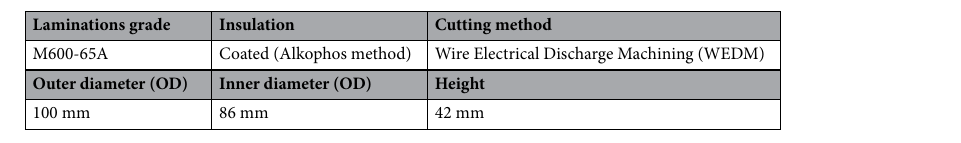
Table 1. Magnetic core